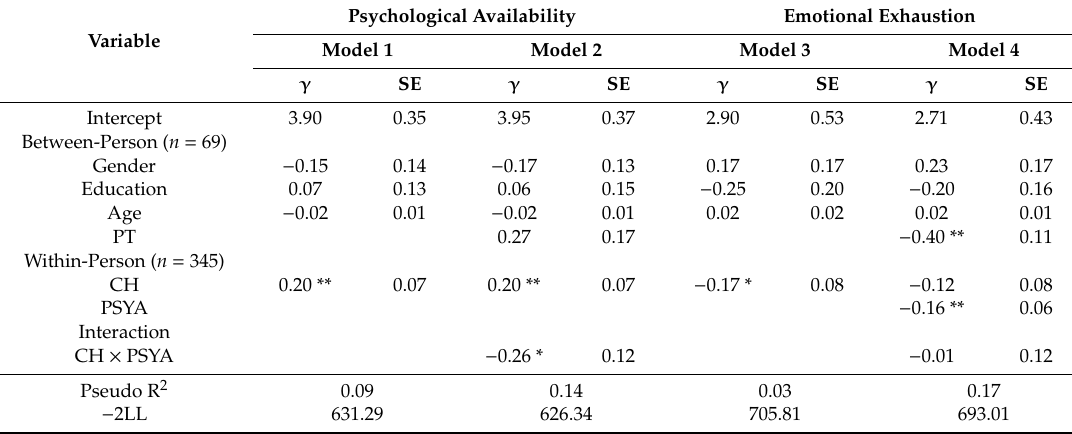
Table 3. Results of hierarchical linear model